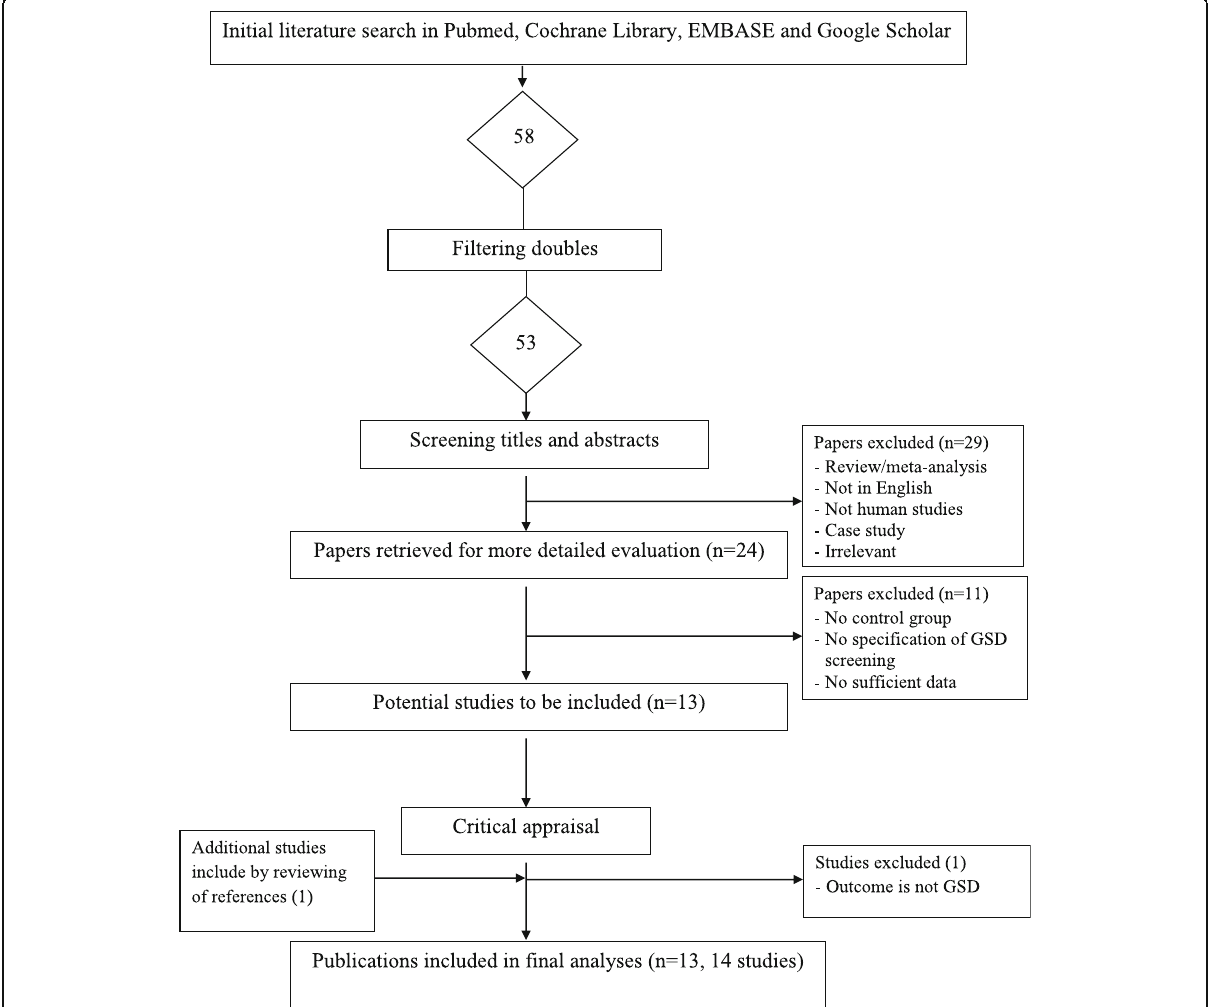
Fig. 1 Flow diagram of the selection process of the studies included in the meta-analyses. Note: Please see the Methods section for additional